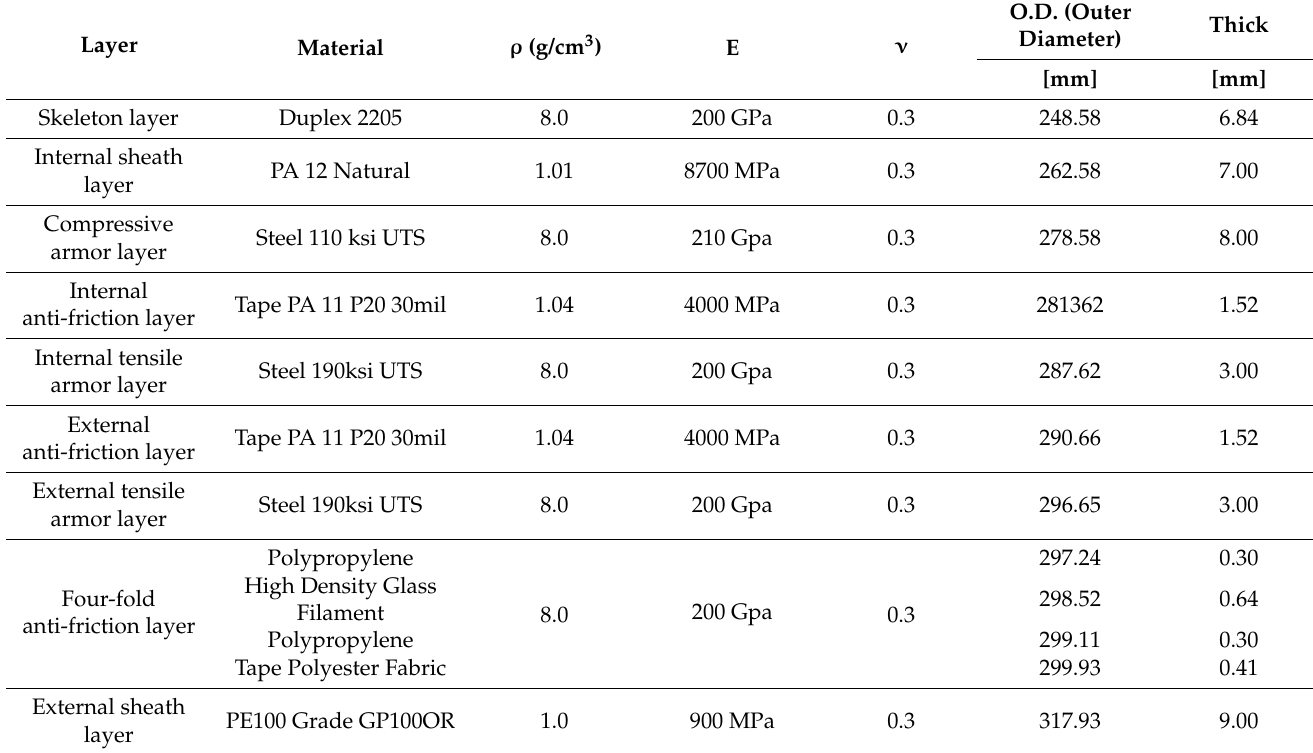
Table 1. The material properties of multilayer risers.